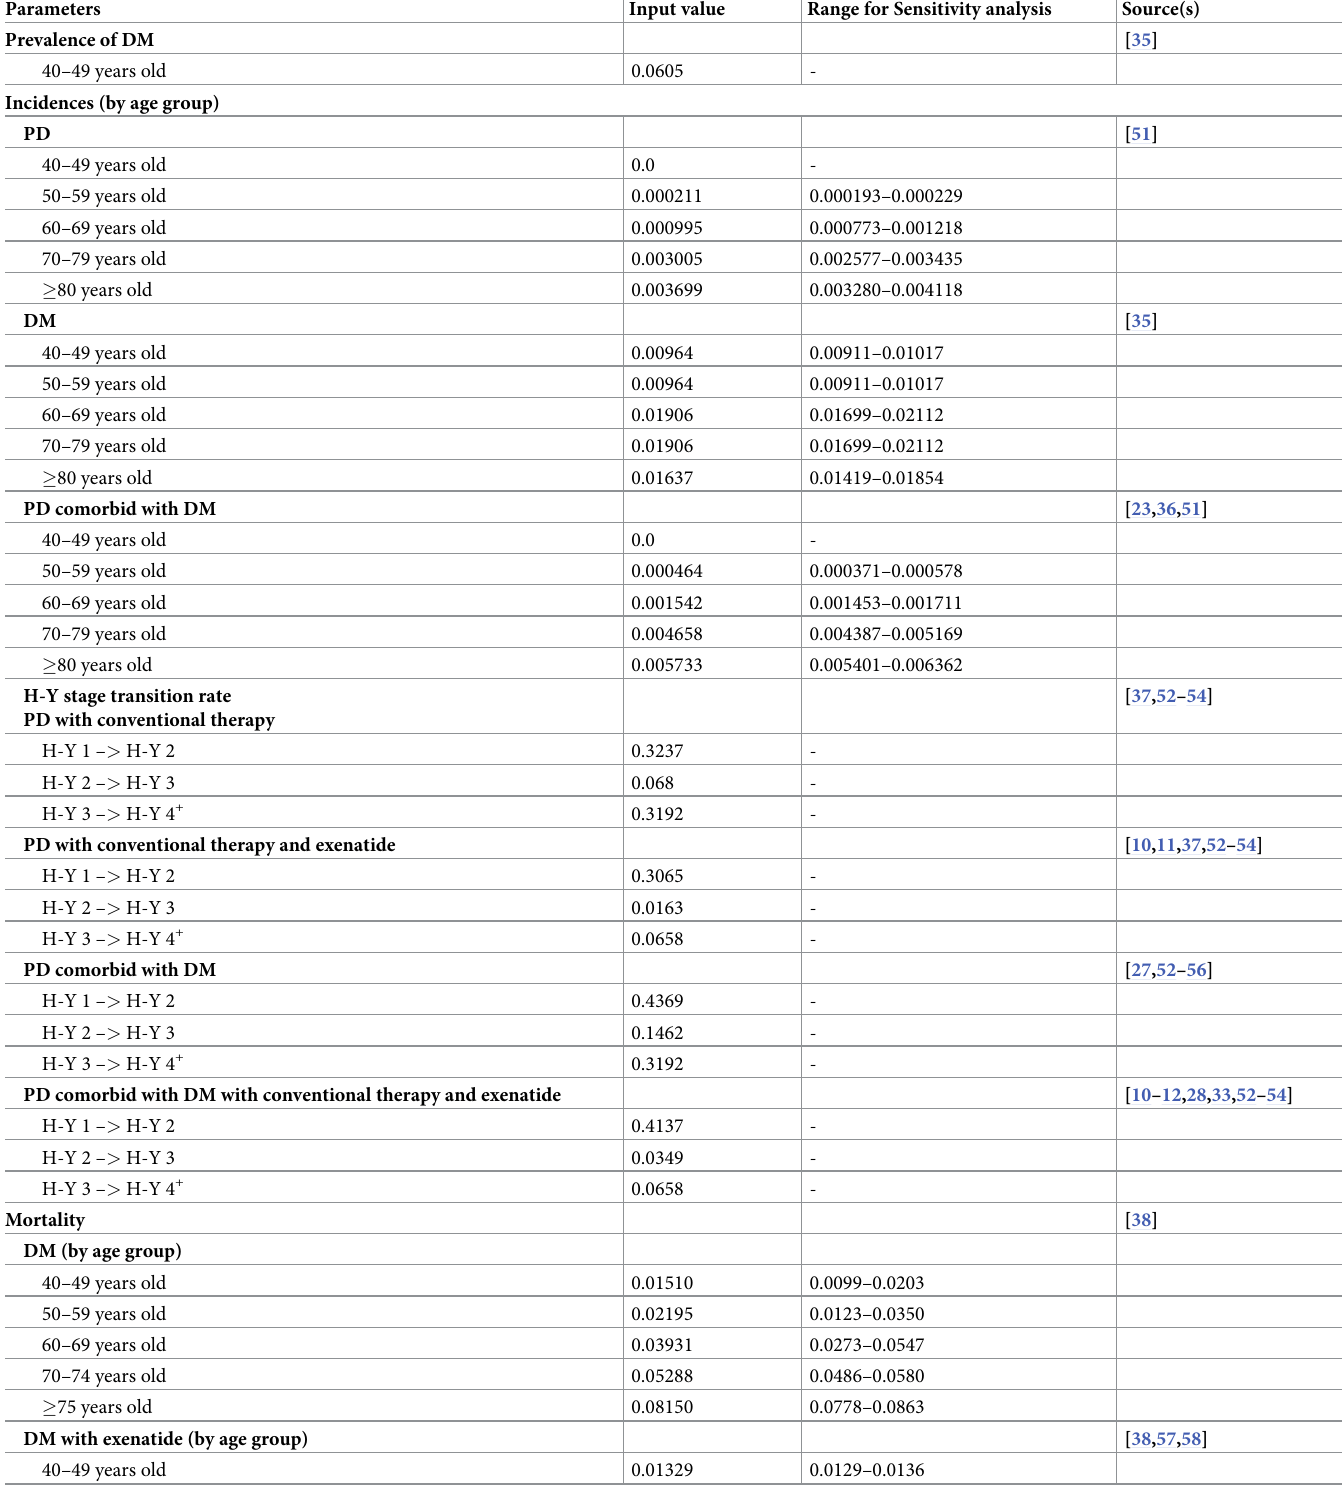
Table 2. Parameter input and data sources for the cost-effectiveness